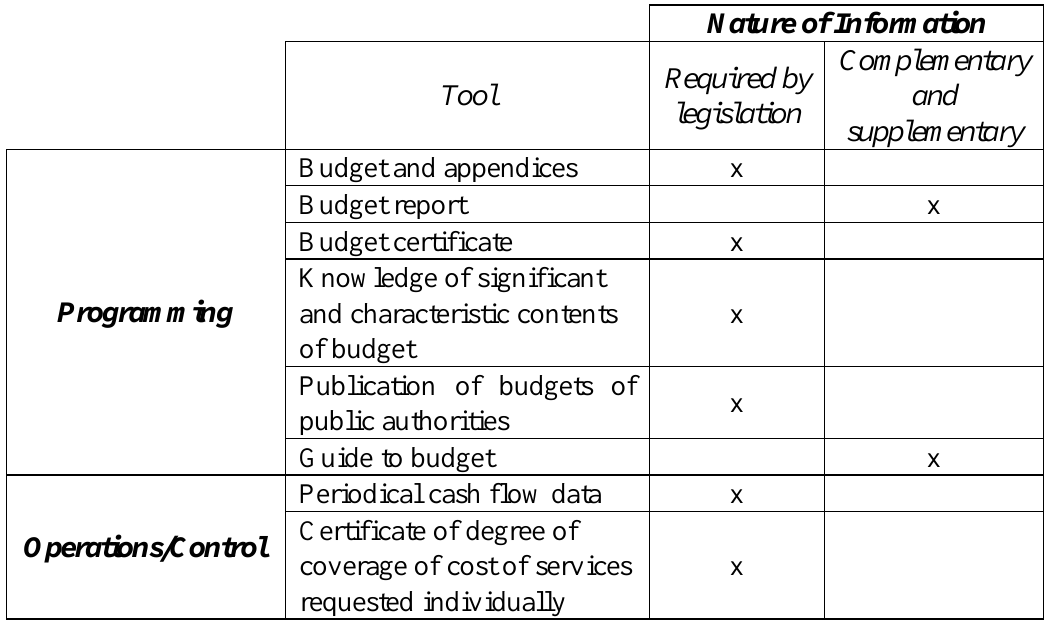
Table 2: Economic-Financial Communication Tools and Compulsory Nature of